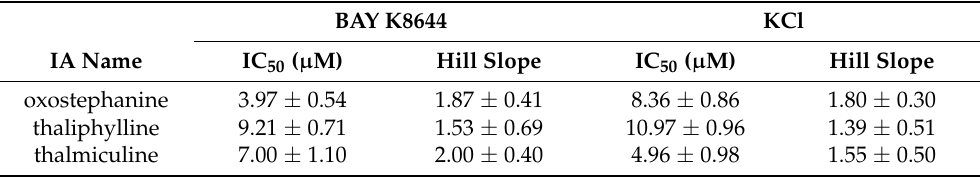
Figure 5. Concentration–inhibition curves for oxostephanine, thalmiculine, and thaliphyline. The curves represent the relationships of concentration–inhibition effects of oxostephanine, thalmiculine, and thaliphyline on Ca 2+ responses induced by 1 µM BAY K8644 ( a ) or by 10 mM KCl ( b ). Data (AUC of Ca 2+ kinetic response) were normalized to maximal response induced by BAY K8644 or by KCl (% of control) alone. Data were best fitted with Hill–Langmuir equation. Data were expressed as means ± SEM ( n = 3). These experiments were repeated thrice. Table 3. IC 50 and Hill slope values for oxostephanine, thaliphylline, and thalmiculine.